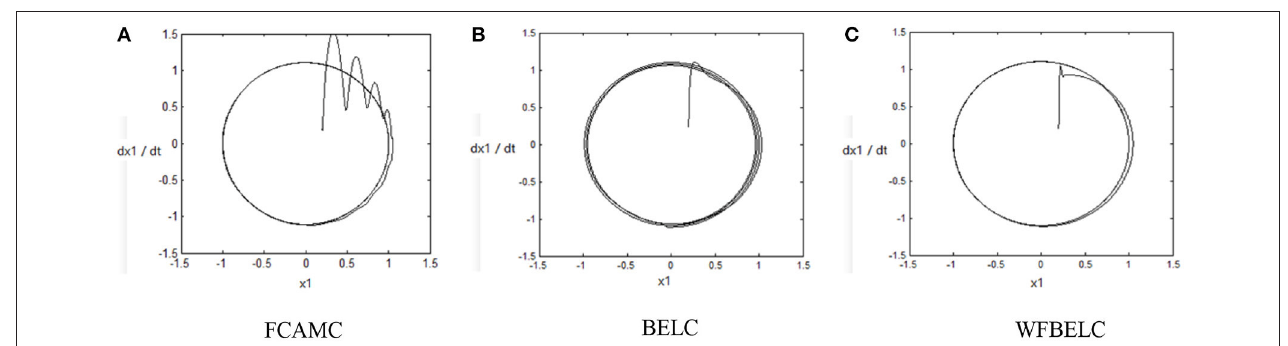
Frontiers in Neuroscience |